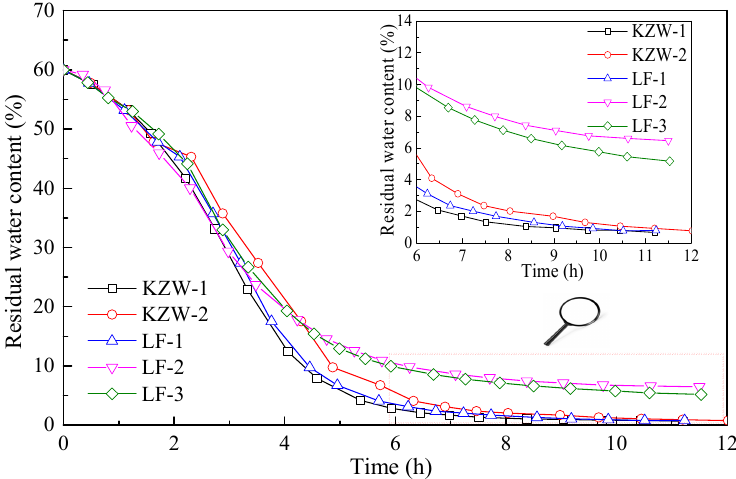
Figure 7. Residual water content of different emulsions during drying. Table 4. Drying parameters of different bitumen emulsions.